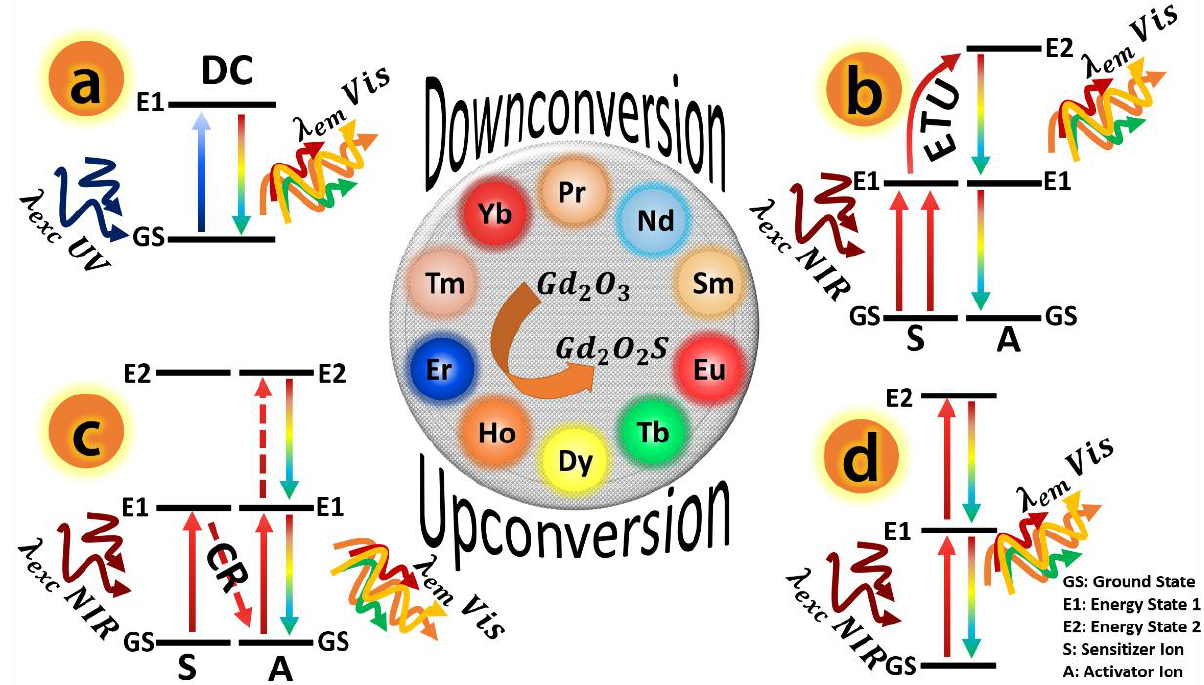
Figure 1. Lanthanide photoluminescence phenomena achieved in gadolinium oxide and oxysulfide materials. The most common mechanisms that involve photoluminescence include the following: ( a ) downconversion (DC), ( b ) energy transfer upconversion (UC-ETU), ( c ) cross-relaxation (UC-CR), ( d ) energy state absorption (UC-ESA) graphically explained in energy level diagrams.